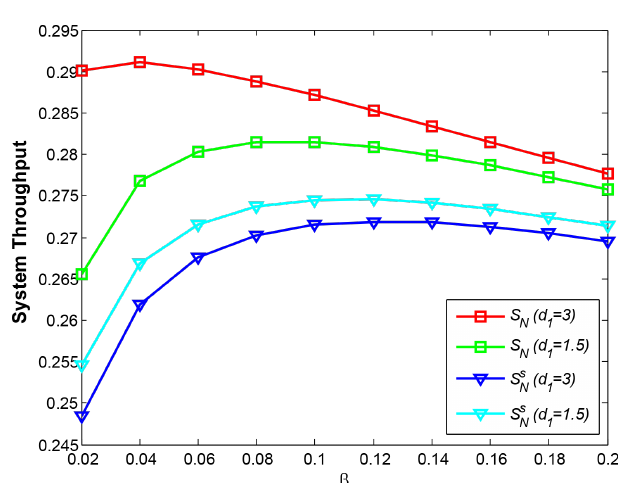
Figure 7. OP vs. β at d 1 = 3.